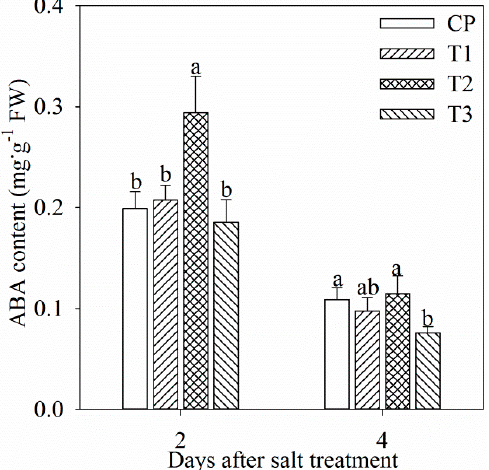
Figure 1. Changes in root abscisic acid (ABA) content in Jerusalem artichoke after salt stress for two days (a) and four days (b). Data in the figure indicate mean of five replicates (±SD), and different letters on error bars indicate significant difference at p < 0.05. CP indicates control plants without pretreatment and NaCl stress; T1 indicates tungstate-pretreated plants without NaCl stress; T2 indicates non-pretreated plants under 150 mM NaCl stress; T3 indicates tungstate-pretreated plants under 150 mM NaCl stress. The symbols, CP, T1, T2, and T3 are also used in the following figures.